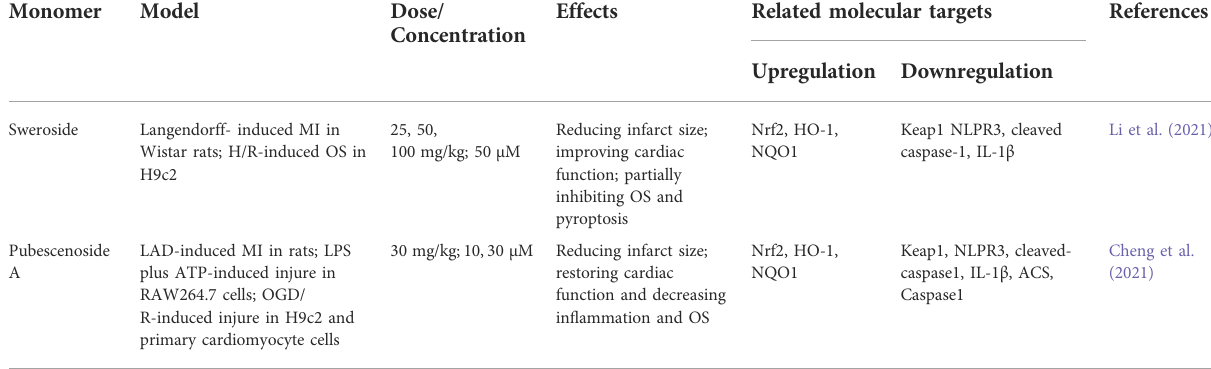
TABLE 5 Protective effects of glucosides on vascular endothelial